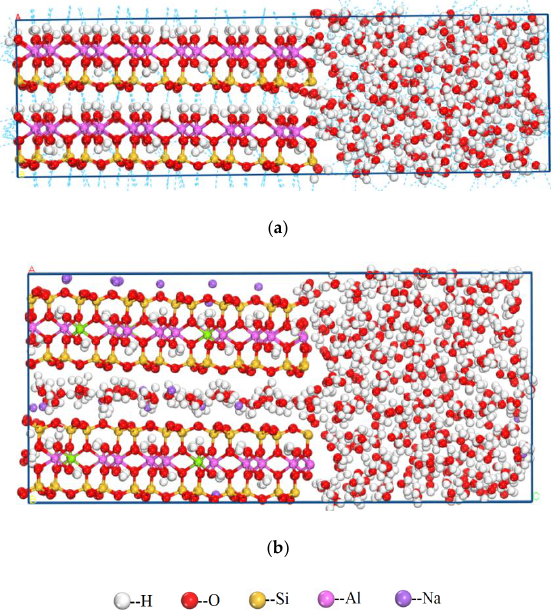
Figure 9. Equilibrium snapshot from an MD simulation of water adsorption on the side surface of ( a ) kaolinite and ( b ) montmorillonite at 298 K and 1 bar.